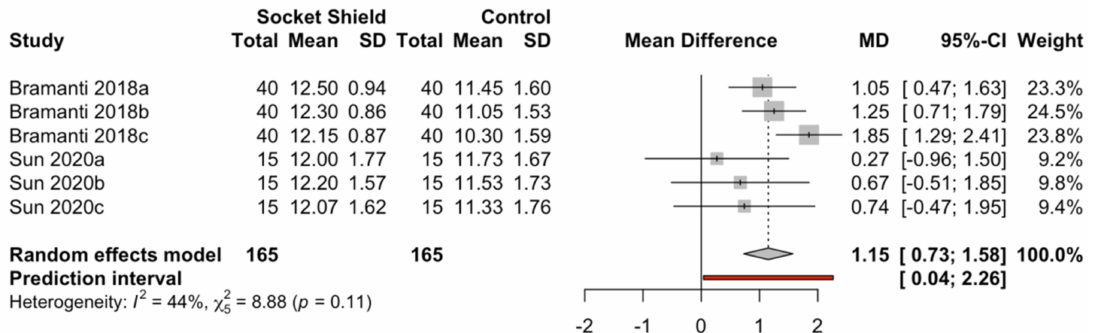
Figure 8. Forest plot of the mean difference in PES between immediate dental implant placement using the socket-shield technique and conventional technique in the esthetic zone.